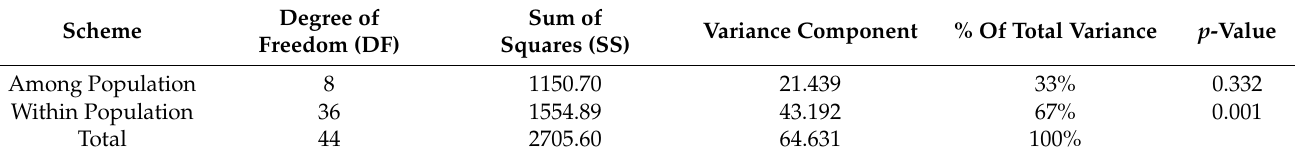
Table 8. AMOVA of bean varieties, using inter primer binding site (iPBS)